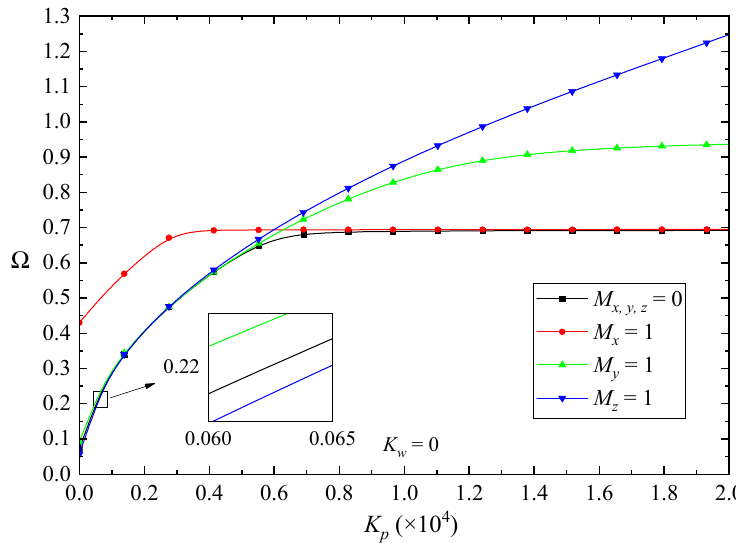
Ω of the beams in